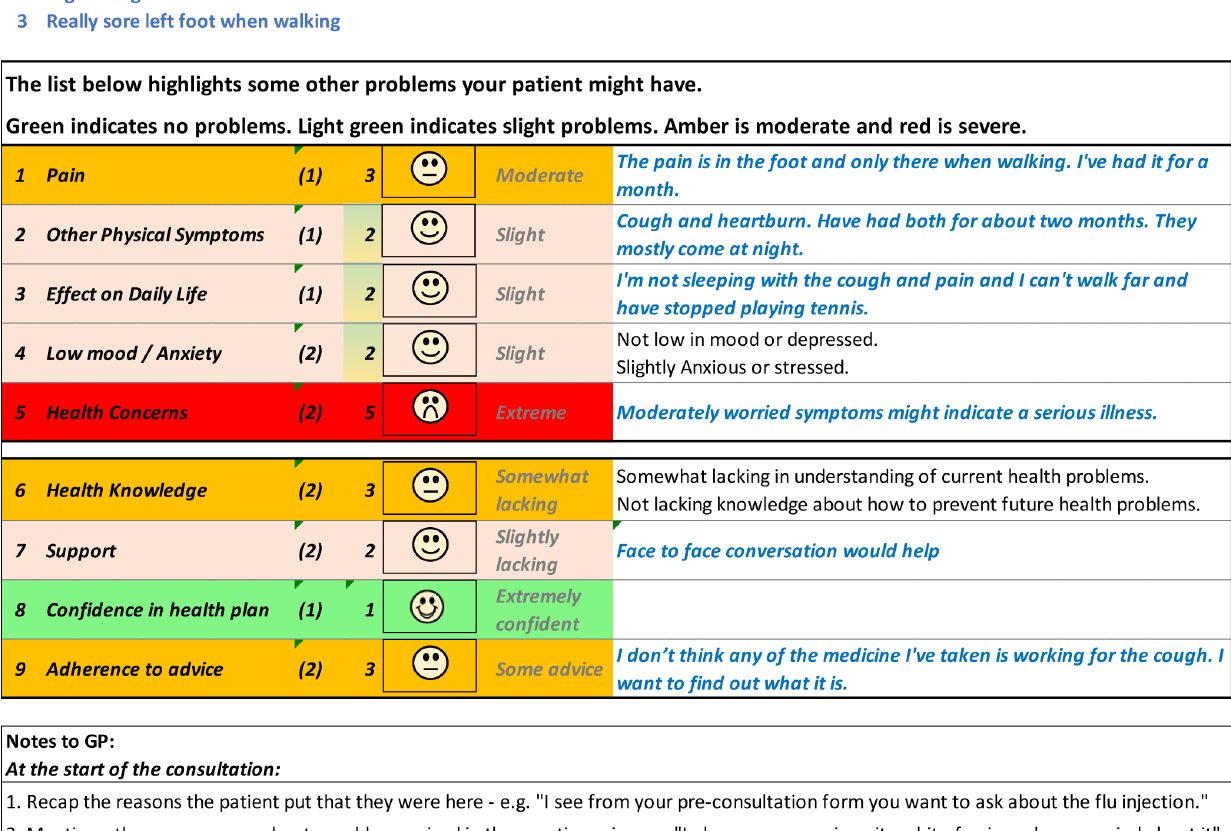
Figure 5. Pre-consultation report: Pilot version (start of intervention